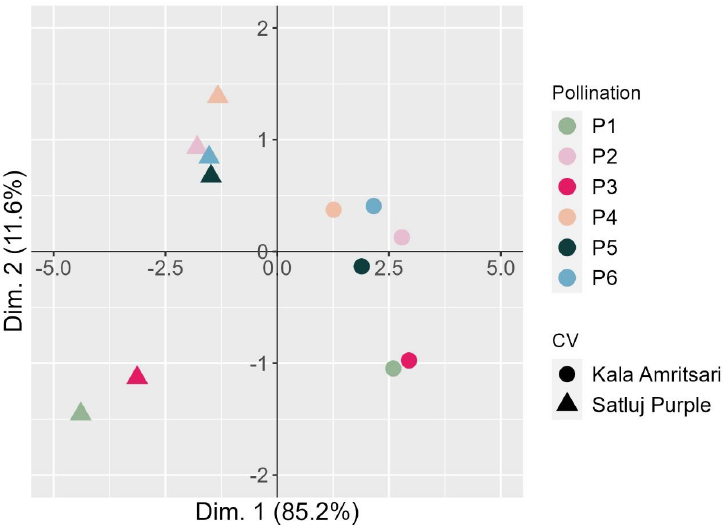
Figure 6. Bi-dimensional PCA plot of the fruit traits of two plum cultivars ‘Satluj Purple’ (triangles) and ‘Kala Amritsari’ (circles) exposed to six pollination treatments: self-pollination (P1), open-pollination with the two cultivars located in adjacent rows (P2), open-pollination with the two cultivars located in distant rows (P3), manual cross-pollination (P4), supplementary pollination (P5) and floral bouquet (P6) . For both varieties, each pollination treatment is colored according to the bar reported on the right-hand side. The plot also reports the percentage of variance explained by each dimension.